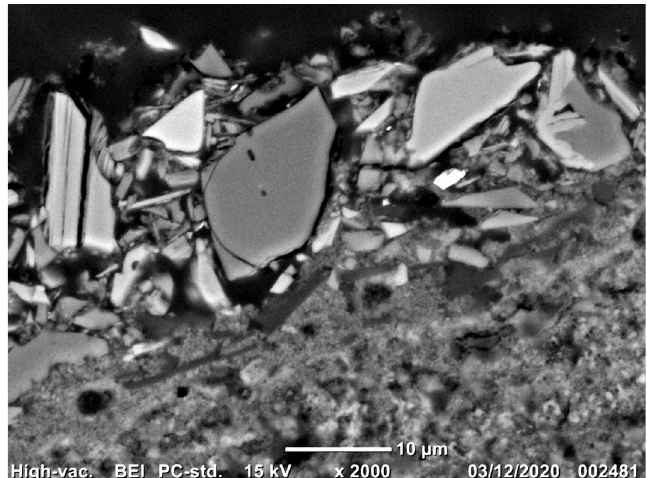
Figure 3. Scanning electron micrograph of a cross-sectional sample of the pictorial layer acquired in backscattered electron imaging mode (BEI). As elements with high atomic numbers cause strong electron backscattering, the brightest particles can be assigned to copper oxides (confirmed by energy dispersive X-ray spectroscopy, data not shown), followed by cuprorivaite appearing slightly darker. The grain on the top right consists of intergrown cuprorivaite and quartz. The barely visible silicate layers in the blue pigment are much more pronounced in micrometric to sub-micrometric particles seen on the